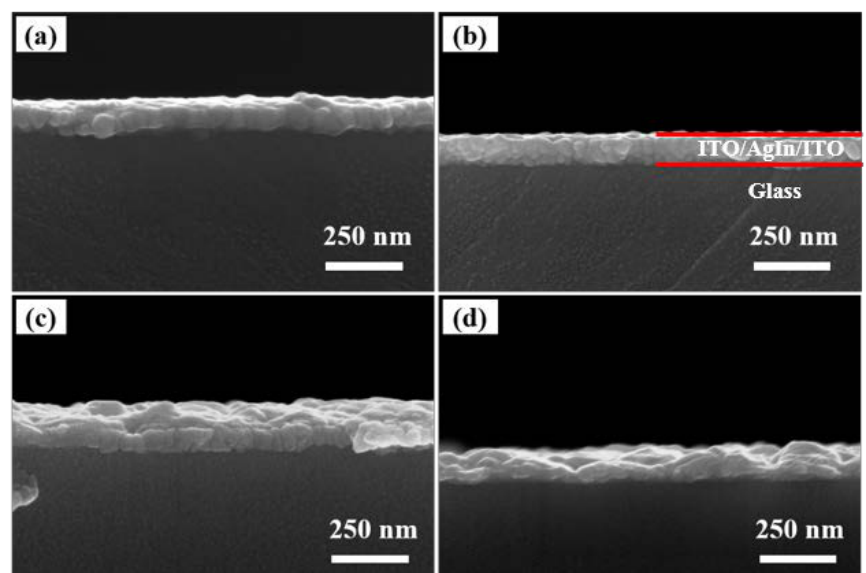
Figure 7. Cross - sectional SEM images of the ITO/AgIn/ITO films at different sputtering Figure 7. Cross-sectional SEM images of the ITO/AgIn/ITO films at different sputtering temperatures. temperatures. ( a ) 25 °C, ( b ) 100 °C, ( c ) 200 °C and ( d ) 300 °C, respectively. ( a ) 25 ◦ C, ( b ) 100 ◦ C, ( c ) 200 ◦ C and ( d ) 300 ◦ C, respectively.